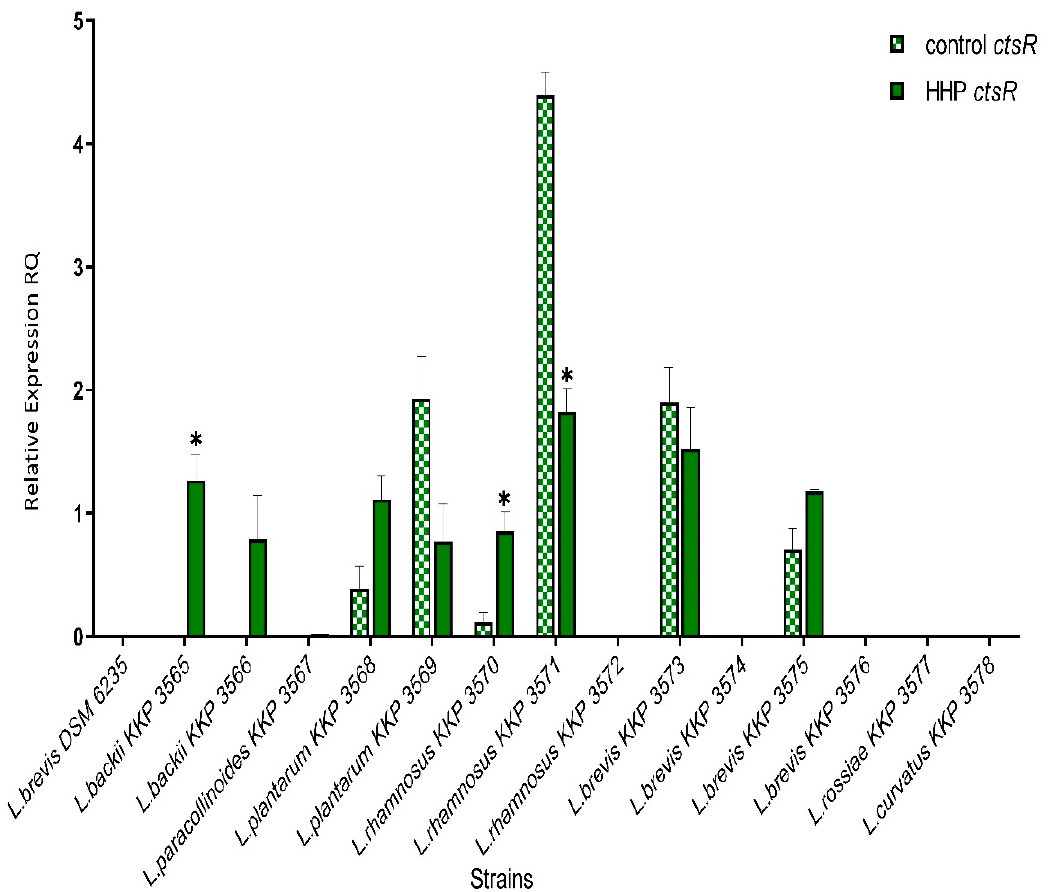
Figure 3. Relative gene expression of ctsR in LAB strains before and after exposure to 300 MPa pressure for 5 min. determined by RT-qPCR analysis. Presented data are the mean of the two independent experiments and the standard deviations are indicated with vertical bars. * Statistically significant differences were determined by Student’s t -test ( p < 0.05).